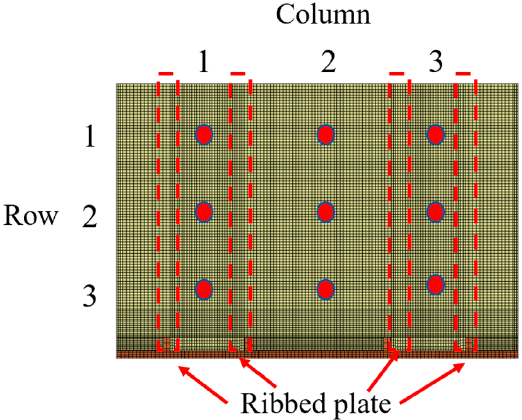
( b ) Figure 7. ( a ) Box chart of velocity response in different RMR. ( b ) Box chart of acceleration response in different RMR. Five groups of tests with RMR of 0% were selected, and nine points were selected on the tail beam. The distribution of points is shown in Figure 8. The mean values of the effective values of the velocity and acceleration signals of each point in the five tests were counted. The results are shown in Figure 9, the vibration signals with large vibration am-